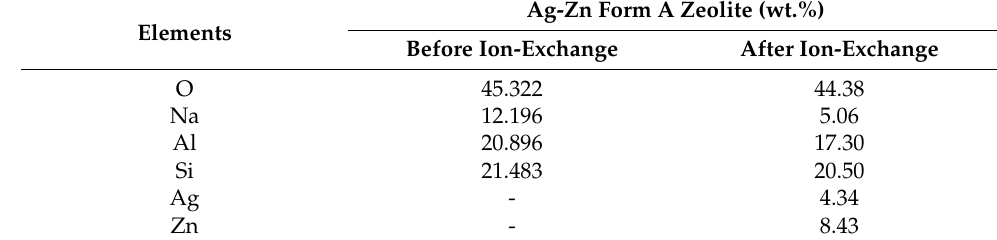
Table 2. Elemental analysis of the prepared A zeolite before and after ion-exchange process.